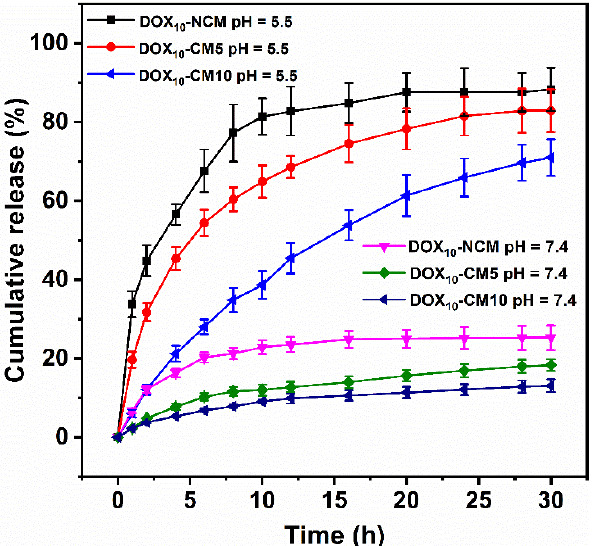
Figure 3. In vitro DOX release profiles from DOX ‐ loaded PEG ‐ b ‐ P(HEMA ‐ ene) ‐ b ‐ PBA micelles in PBS buffer at pH 5.5 and 7.4 at 37